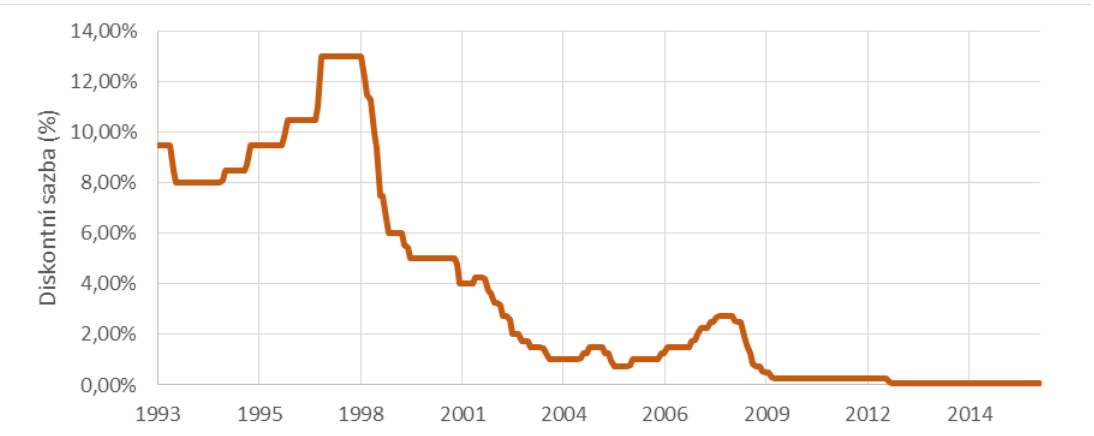
Obrázek 2: Nastavení diskontních sazeb dle ČNB 1993-2013 (úročení depozit komerčních bank u ČNB). [7] Předpoklad ztíženého investování lze odečíst ze všech vyšších hodnot zobrazených jak v Obrázek 1, tak v Obrázek 2. Dopad na situaci na trhu nemovitostí tehdy a dnes poskytuje řadu paralel. Jedna Pokud je v následujícím textu použit obrat Česká republika či ČR, rozumí se tím geografická